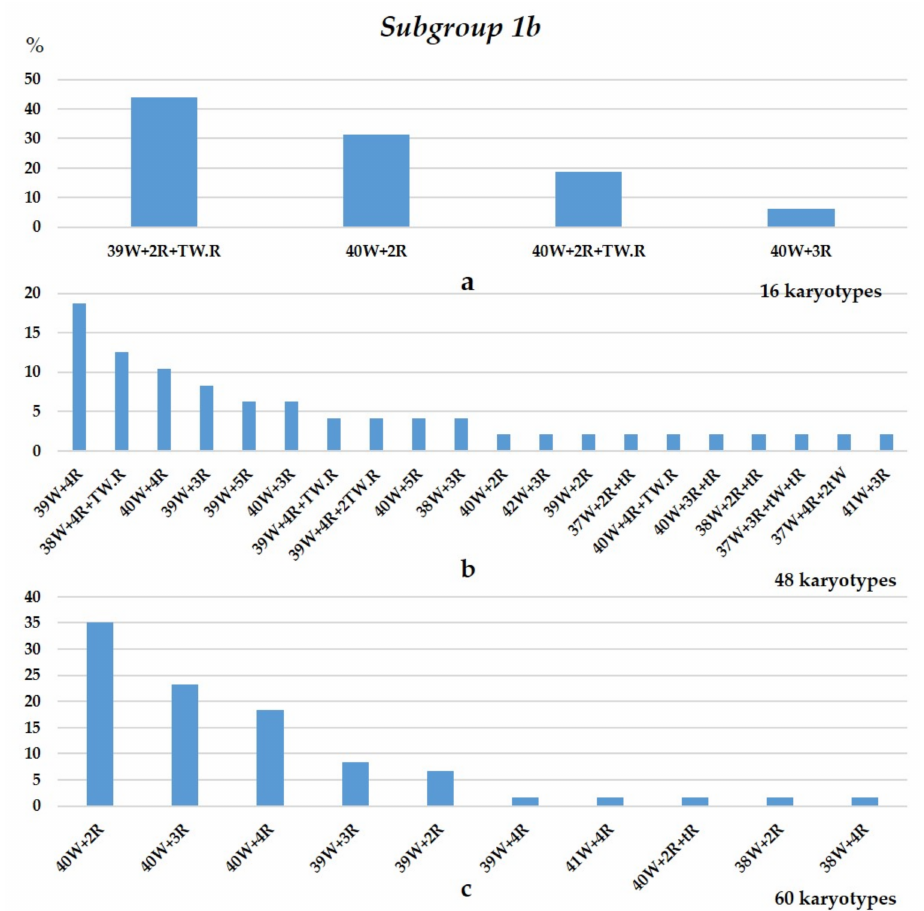
Figure 6. Frequencies of different chromosome sets in the plant karyotypes of subgroup 1b: ( a ) 23-8 plant progeny; ( b ) 23-10 progeny; ( c ) 23-13 progeny. Designations follow Figure 4. Chromosome sets in the progeny of plant 23-8 (Figure 7a) formed three major groups: 39W+1R1R+T1BL.1RL (43.75%) (Figure 6a), 40W+1R1R (31.25%), and 40W+2R+T1BL.1RL (18.75%). The three major groups in the progeny of 23-13 were 40W+1R1R (35%), 40W+1R1R+2R (23.33%), and 40W+1R1R+2R+7R (18.33%) (Figure 6c). Wheat chromosomes were in the disomic state with few exceptions (3A, 2D, and 4B were monosomic). A different pattern was observed in the progeny of plant 23-10. Their chromosome sets were more diverse: a total of 20 different sets were found (Figure 6b). The most frequent chromosome sets were 39W+1R1R+2R+7R (18.75%), 38W+1R1R+2R2R+T2RL.W (12.5%), and 40W+1R1R+2R+7R (10.41%). The numbers of rye chromosomes varied from two to five. The 40W+1R1R set was found in only one plant. Sets with wheat and rye telocentrics and with Robertsonian translocations were found in 33.33% of plants. The translocated chromosomes had hybrid centromeres because the centromeric repeats pAet6-09 and pAWRc did not overlap (Figure